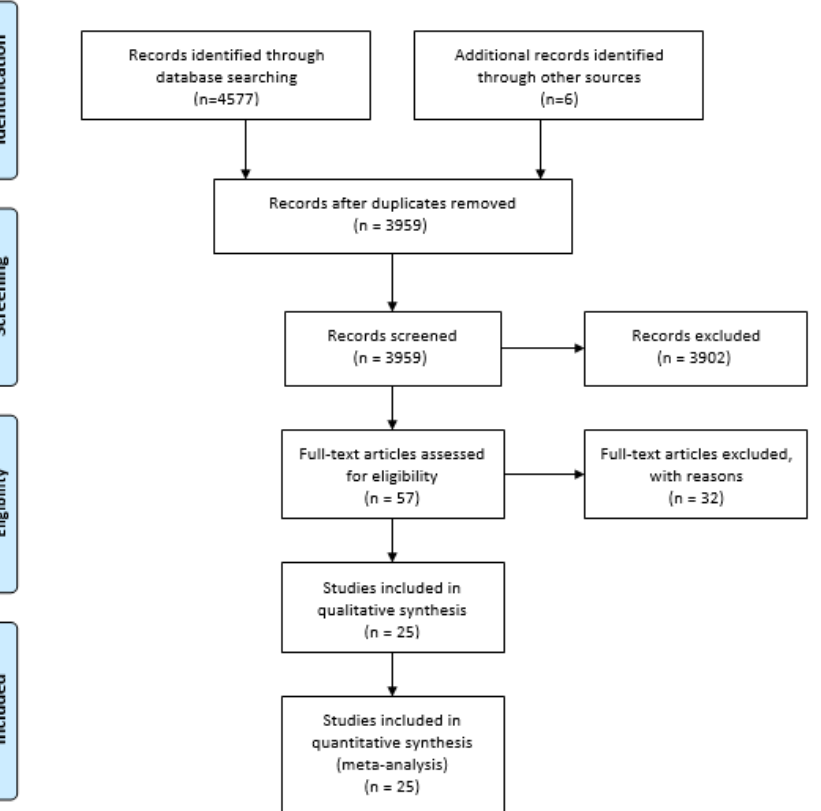
Figure 1. Preferred Reporting Items for Systematic Reviews and Meta-Analyses (PRISMA) flow diagram.